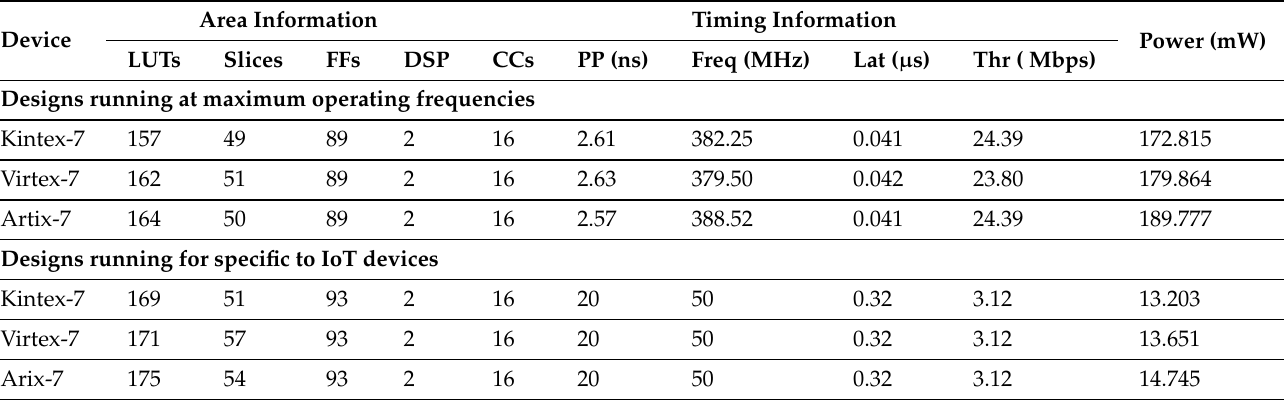
Table 2. Results after post-place-and-route for SIMECK32/64 over 7-series FPGA